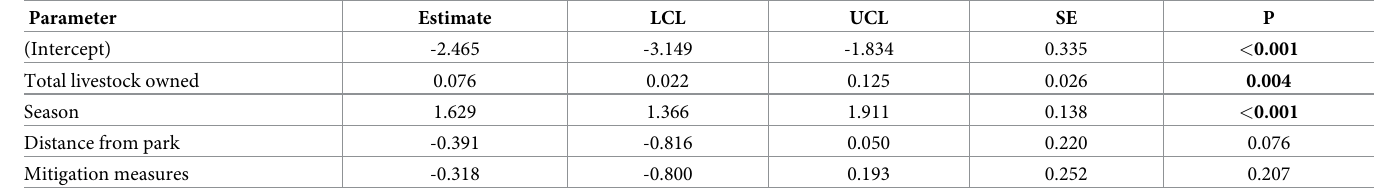
Table 2. Model-averaged parameter estimates with lower (LCL) and upper (UCL) 95% confidence limits describing livestock depredations by wildlife in Shukla- phanta National Park, Nepal, 2016–2021. Number of livestock killed was used as the response variable and total number of livestock owned, season (summer and win- ter), distance from the park (near: < 500 m and far: > 500 m from the park boundary) were predictor variables. From which best supported model and successive models were generated and parameter estimates were averaged from all models. Significant effects are in